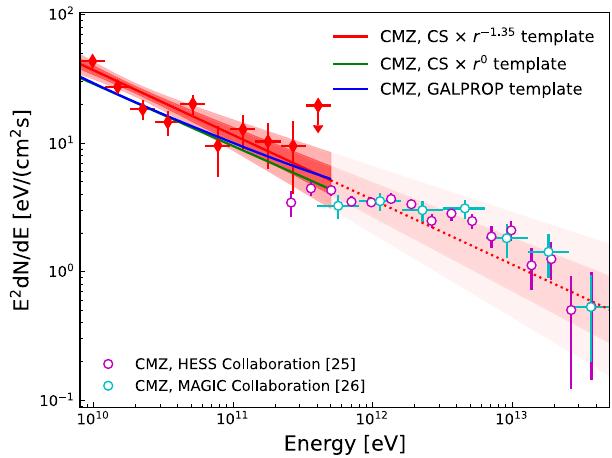
Fig. 4 Spectral energy distribution of γ - ray emission contributed by the CMZ component. Red fi lled dots show results obtained in this work, open circles in magenta show measurement by H.E.S.S. 25 and open circles in cyan show measurement by MAGIC 26 . The red solid line and associated dark and light bands show the best- fi t power-law model and the 68 and 95% con fi dence ranges, respectively, for the CS × r − 1.35 template. The error bars represent the 1 σ statistical uncertainties and the upper limit is at the 95% con fi dence limit. Best- fi t power-law models for the CS × r 0 template and the GALPROP H 2 template are also shown in green and blue solid lines as a comparison. The lighter red band and the red dotted line above 500 GeV are extrapolations from the low energy fi tting for the model with CS × r − 1.35 template. Source data are provided as a Source Data fi le. 3 × 10 7 M ⊙ 29,34 and the nuclear enhancement factor η N = 1.5 for heavier nuclei (see “ Methods ” , subsection The CR densities in the CMZ and off-CMZ regions), we have ω CR = (4.5 ± 0.3) × 10 − 2 eV cm − 3 in the CMZ, which is close to the local CR density of ~4.3 × 10 − 2 eV cm − 3 in the same energy range 35 . The proton number density above 10 GeV, which is (4.3 ± 0.3) × 10 − 12 cm − 3